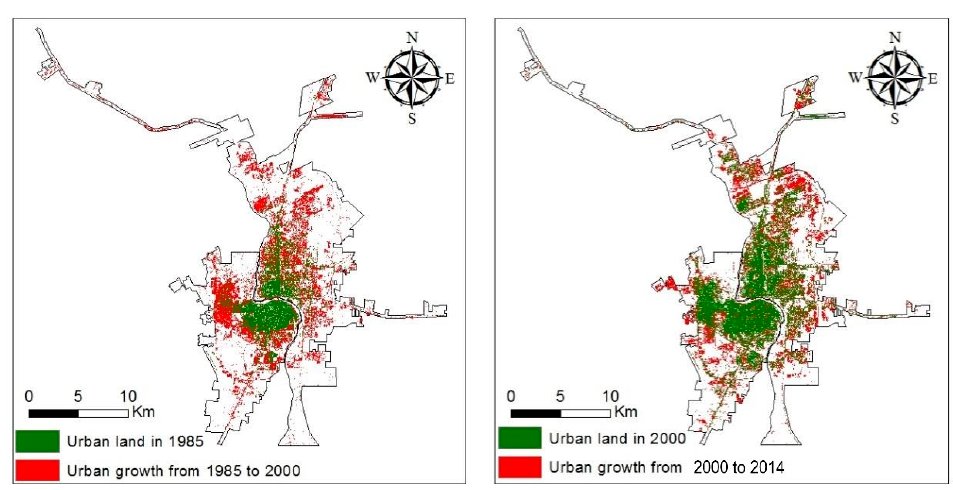
Figure 2. Spatial and temporal patterns of urban growth during 1985–2000 and 2000–2014, Laredo– Nuevo Laredo.